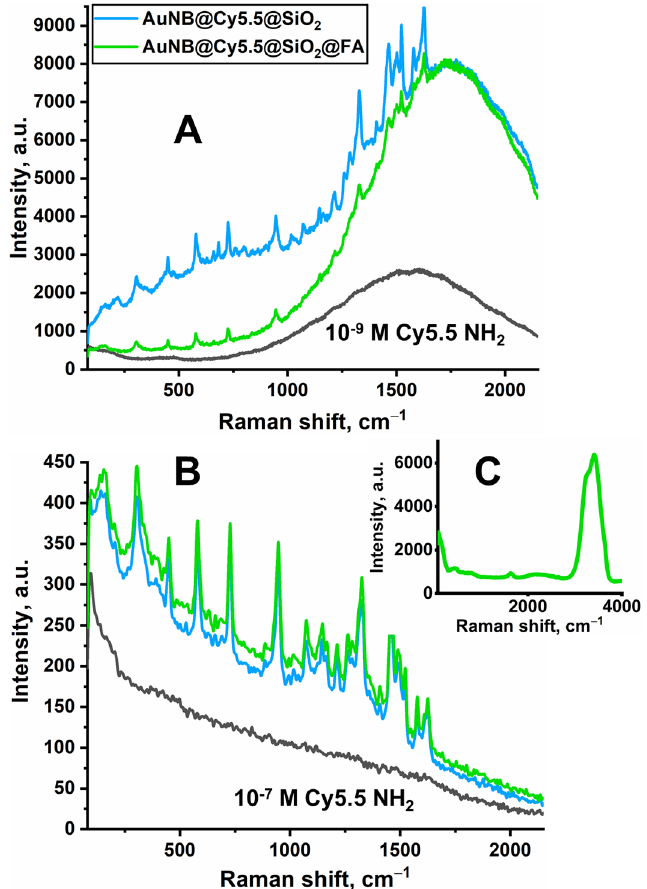
Figure 5. SERS spectra of nanotags colloidal solutions before and after functionalization with folic acid recorded under excitation with 632.8 nm ( A ), 785 nm, ( B ) and 532 nm ( C ) lasers. To show fluorescence nature of baseline in the SERS spectra, parts ( A , B ) include the spectra of cyanine 5.5 amine aqueous solutions obtained under the same acquisition parameters.